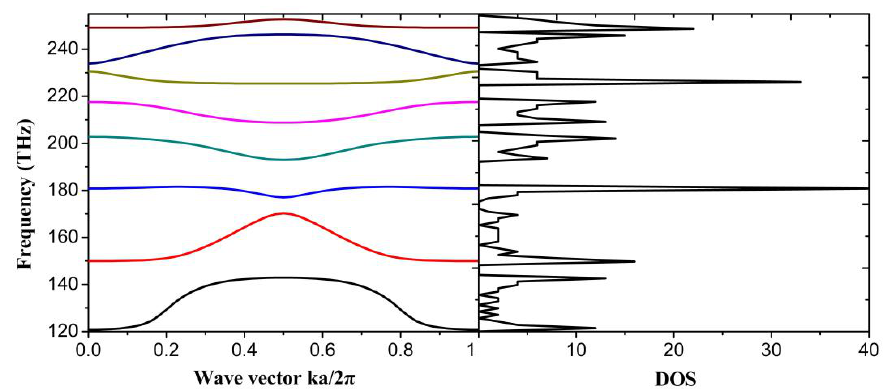
Figure 3. Band structure ( left ) and density of states (DOS) ( right ) of graphene-based plasmonic 1D PhC with chemical potential of 0.9 eV, and lattice constant a = 10 nm.